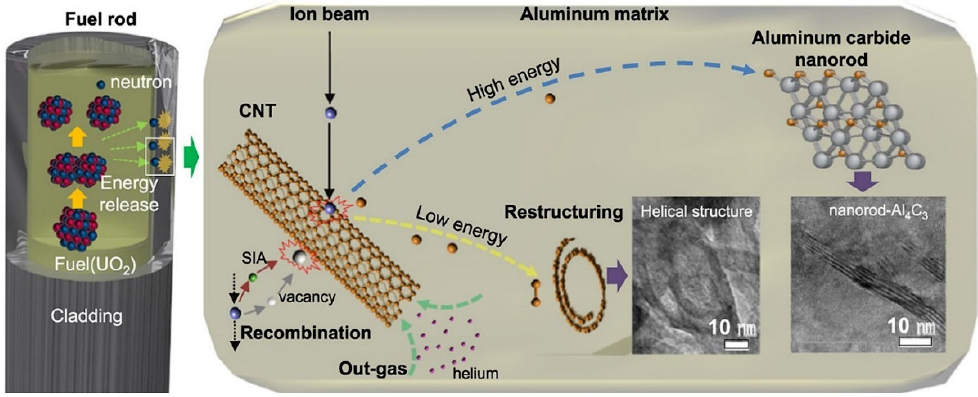
Figure 14. Schematic diagram of irradiation process for CNT/A1 materials [17].